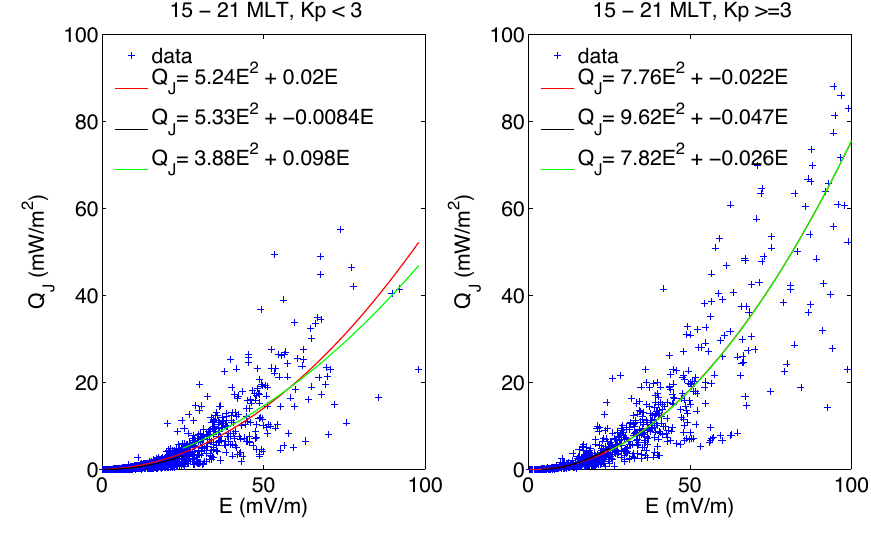
Fig. 15. Same as Fig. 14, but in the evening